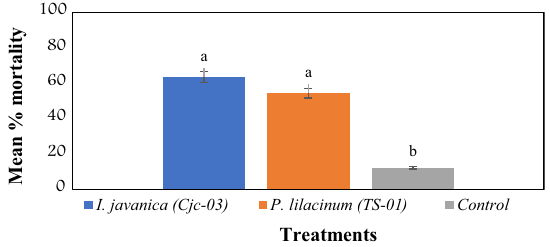
(Fig. 7) and I. javanica was the most effective against adults of B. tabaci.